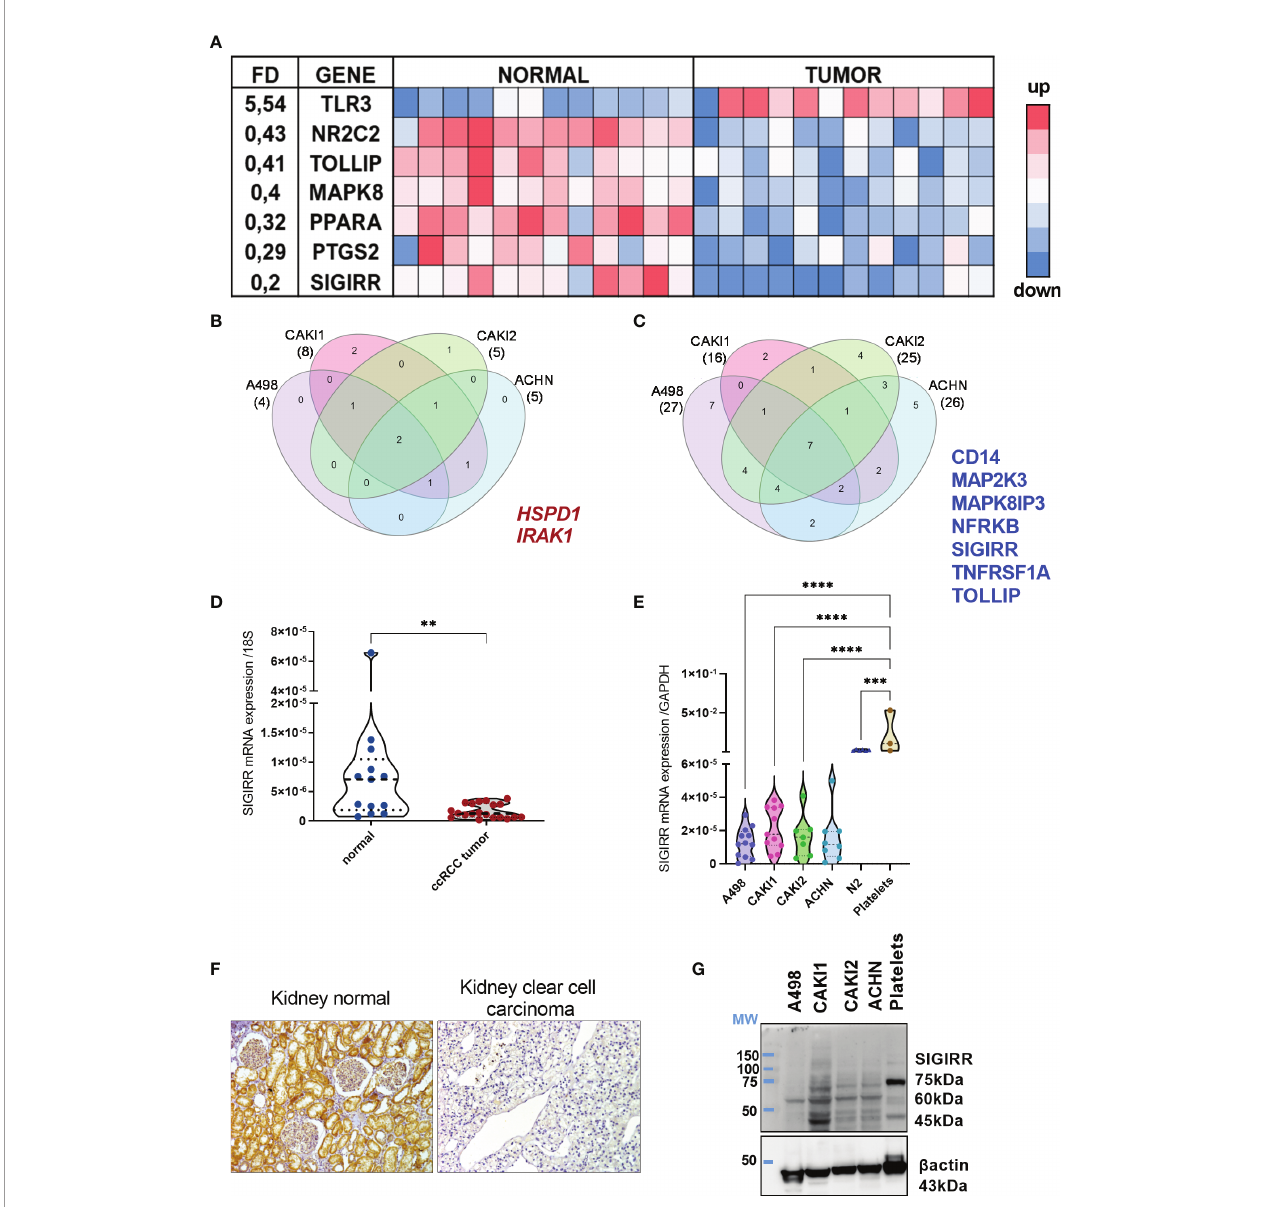
FIGURE 1 | Immune signaling molecules in normal versus tumor kidney. (A) TLR signaling pathway-related molecules were analysis using real-time PCR arrays. Eighty-four genes listed in Supplementary Table 1 were screened in 12 patients ’ samples including coupled normal and malignant tissues. Heat map shows the genes differentially expressed (i.e., with a fold difference (FD) FD >2.0 or FD <0,5 and p-value <0.01). A three-color formatting scheme was used with blue indicating downregulated and red upregulated. (B, C) RCC cell lines were analyzed by real-time PCR array (same as in (A) ) and compared to N2 normal renal cell lines to identify the genes up- and down- regulated; Venn diagram shows the shared upregulated (B) and downregulated (C) genes in each RCC cell line analyzed and highlights the genes shared by all the cell lines. (D) qRT-PCR analysis of SIGIRR mRNA expression in normal kidney tissue (n = 13) compared to ccRCC patients ’ sample (n = 21) **p < 0.01. Data are expressed as mean ± SEM relative to 18S expression. (E) qRT-PCR analysis of SIGIRR mRNA expression in RCC cell lines, in normal epithelial kidney cell line N2, and in platelets used as positive control. ***p<0,001; ****p < 0.0001. Data are expressed as mean ± SEM relative to GAPDH expression. (F) Micrograph of IHC performed using an antibody speci fi c for SIGIRR (long isoform). One representative clear cell carcinoma sample is shown compared to normal kidney tissue. (G) Western blot analysis of SIGIRR expression on whole- cell extracts of A498, CAKI1, CAKI2, ACHN RCC cell lines, and platelet extract. B-Actin was used as loading